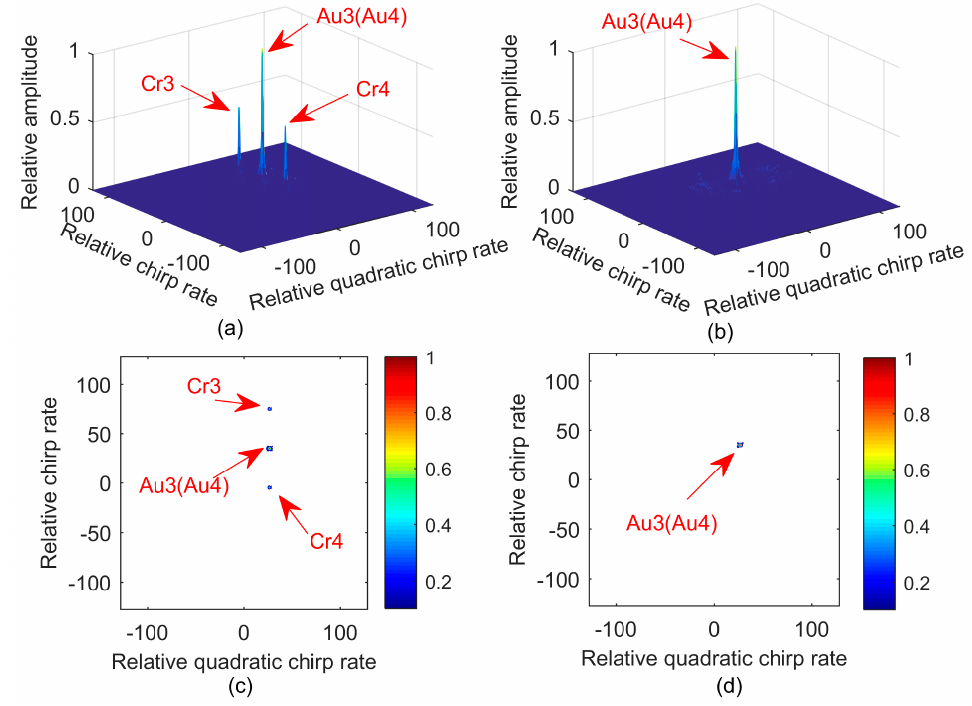
Figure 2. Simulation of Example 2. ( a ) Stereogram with MLVD; ( b ) Stereogram with 2D-PMLVD; ( c ) Contour with MLVD; ( d ) Contour with 2D-PMLVD.